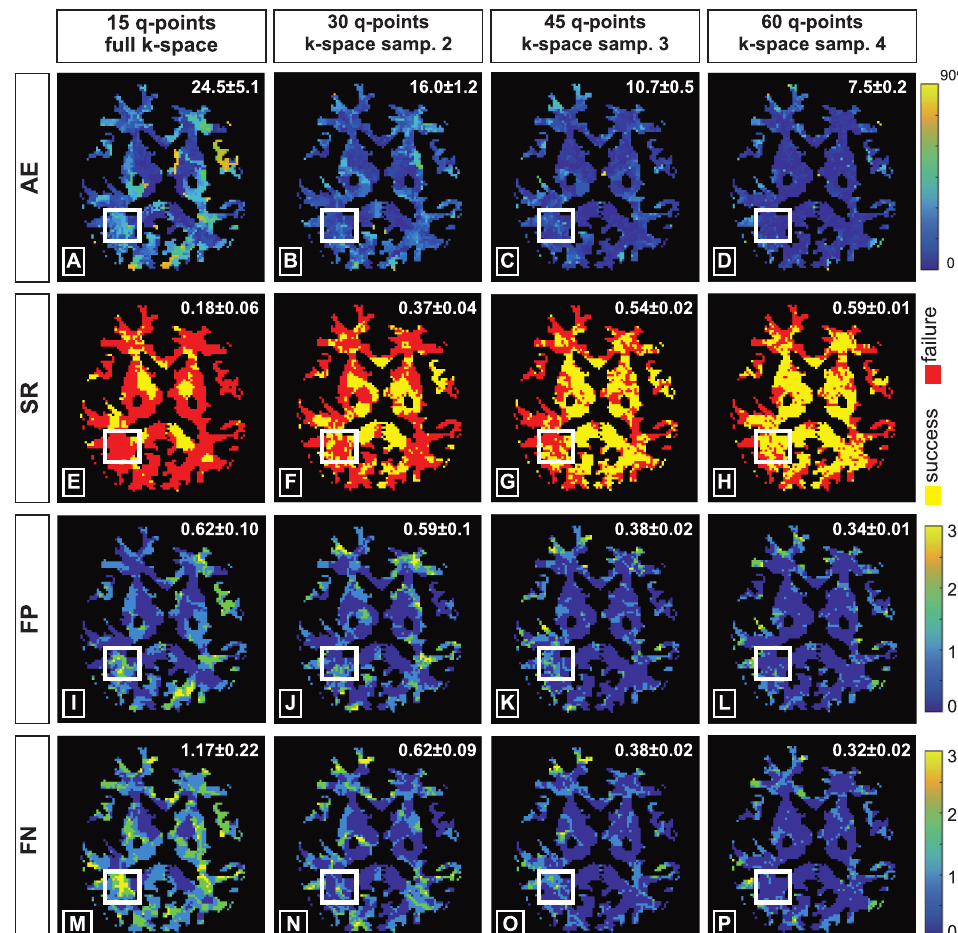
Figure 7. Quantitative evaluation of the fiber orientation reconstruction performed on the real data by using the proposed kq-space under-sampling framework. Reconstructions considering 15 diffusion gradients with full k-space ( first column ), 30 diffusion gradients with k-space under-sampling factor of 2 ( second column ), 45 diffusion gradients with k-space under-sampling factor of 3 ( third column ) and 60 gradient with k-space under-sampling factor of 4 ( fourth column ) were compared with the fiber configuration obtained using 60 q-points and full k-space. The maps of the mean angular error ( first row ), success rate ( second row ), false positives ( third row ) and negatives ( fourth row ) are considered for the